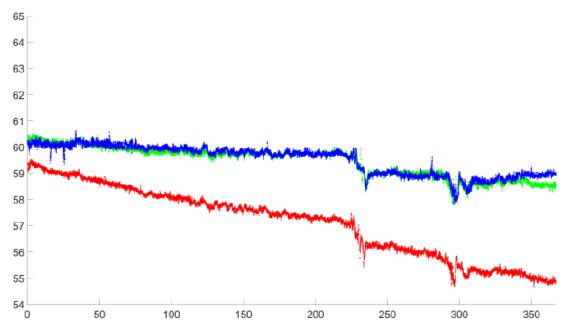
Table 3. Summary statistics of the distance between overlapping Figure 20. East-West profiles, 1 m thick, for Blocks 3 (blue point clouds line), Block 4 before ICP registration (red line) and after that (green line) in the overlapping